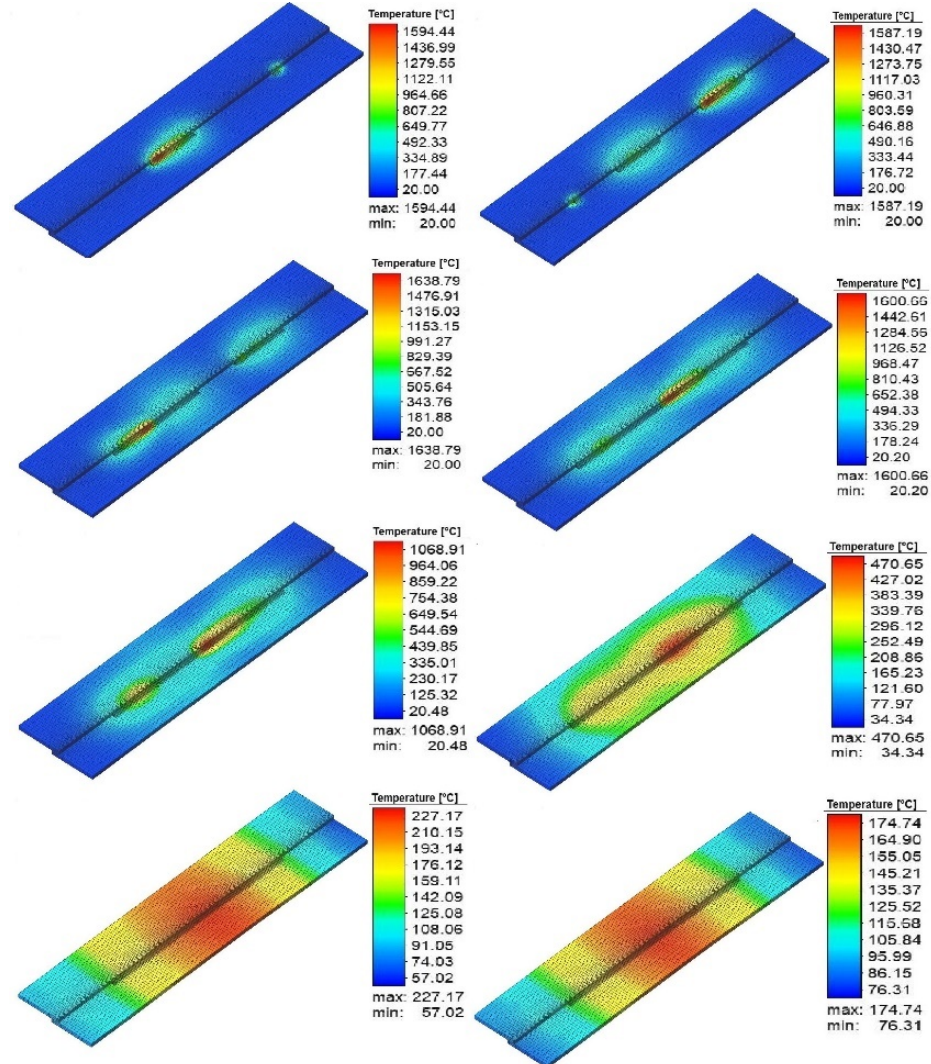
Figure 13 . Temperature profile of 4 weld segments and cooling phase of base metal . Figure 13. Temperature profile of 4 weld segments and cooling phase of base metal.